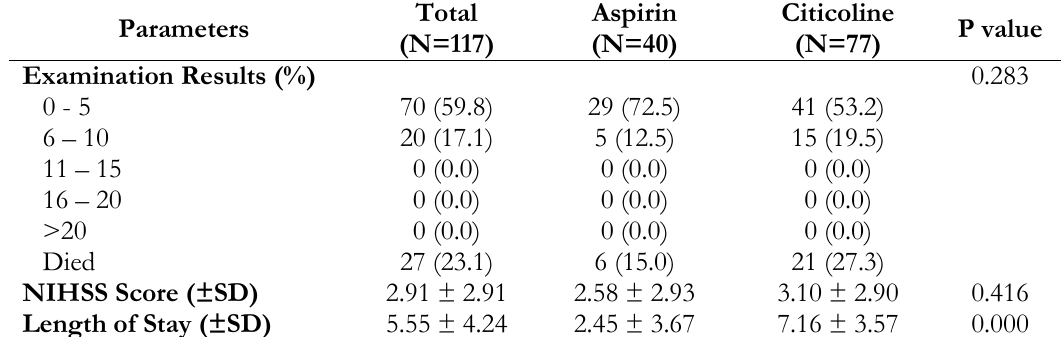
Tabel III. NIHSS health level examination and length of stay of stroke patients in Prof Dr Margono public